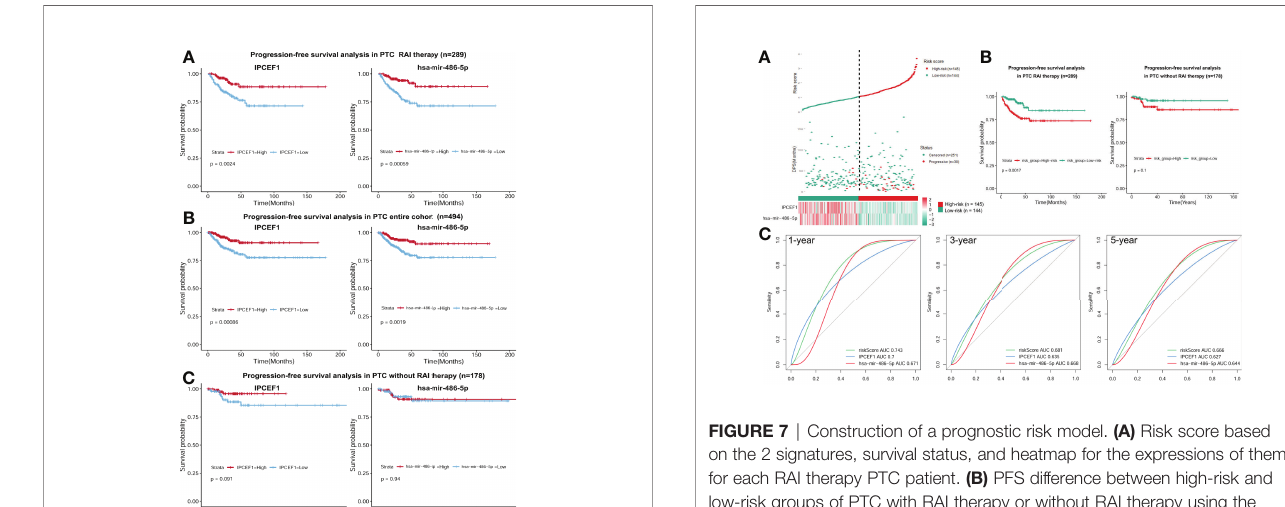
TABLE 3 | Multivariate analysis of the progression-free survival in RAI therapy cohort. Variable